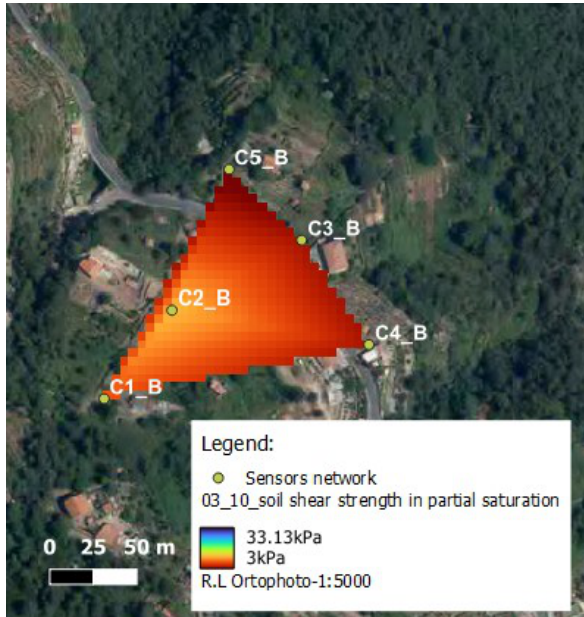
Figure 9. The shear strength surface induced by partial saturation referring to 03/10/2020, after the Alex Storm.